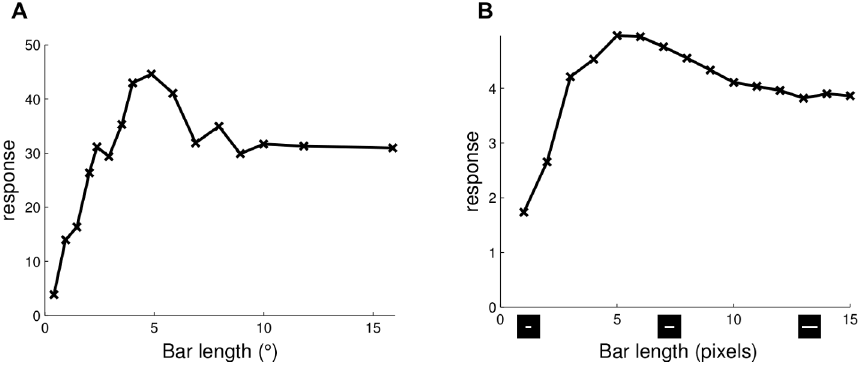
Figure 2. End-stopping. (A) End-stopping response in a simple cell from cat V1 responding to an optimally-oriented light bar stimulus (data replotted from [32], Figure 1). (B) The length tuning curve of a simulated sparse coding model neuron (target) demonstrates end-stopping behavior.